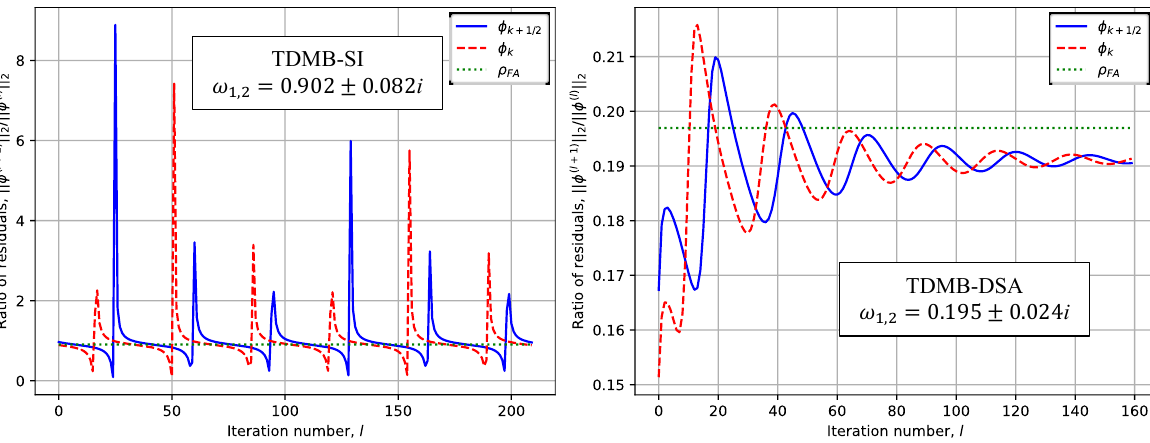
Figure 3. (Color online) Ratio of residuals in iteration number for spectral radius verification of TDMB - SI (left) and TDMB - DSA (right). 𝜌 radius and the complex conjugate leading eigenvalues of the iteration matrix, respectively.